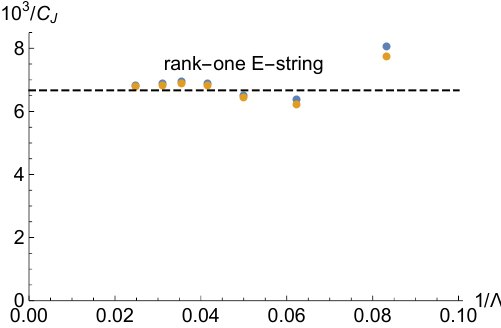
Figure 5 . Left: the upper and lowers bounds on the inverse of the central charge C (cid:0) 1 the value of the (cid:13)avor central charge C J is set close to saturating the lower bound, C J = (1 + 10 (cid:0) 4 ) min C J , at di(cid:11)erent derivative orders (cid:3), for interacting theories with E 8 (cid:13)avor group. Also shown is the value for the rank-one E-string theory. Right: the same plot zoomed in on high derivative orders, showing a trend that the value of C T at min C J potential approaches the rank- one E-string value as (cid:3) ! 1 .